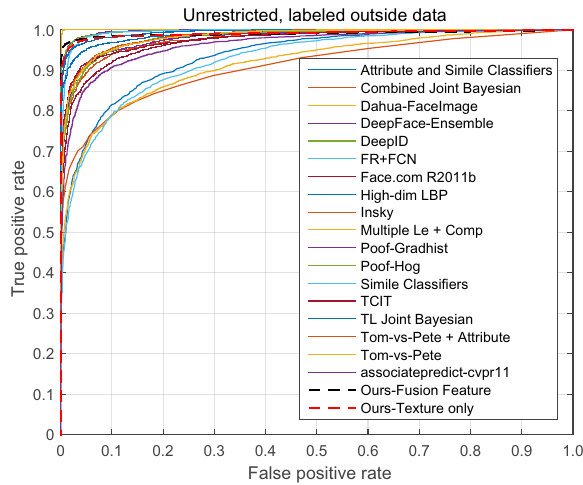
Fig. 8 ROC comparison with previous best methods using